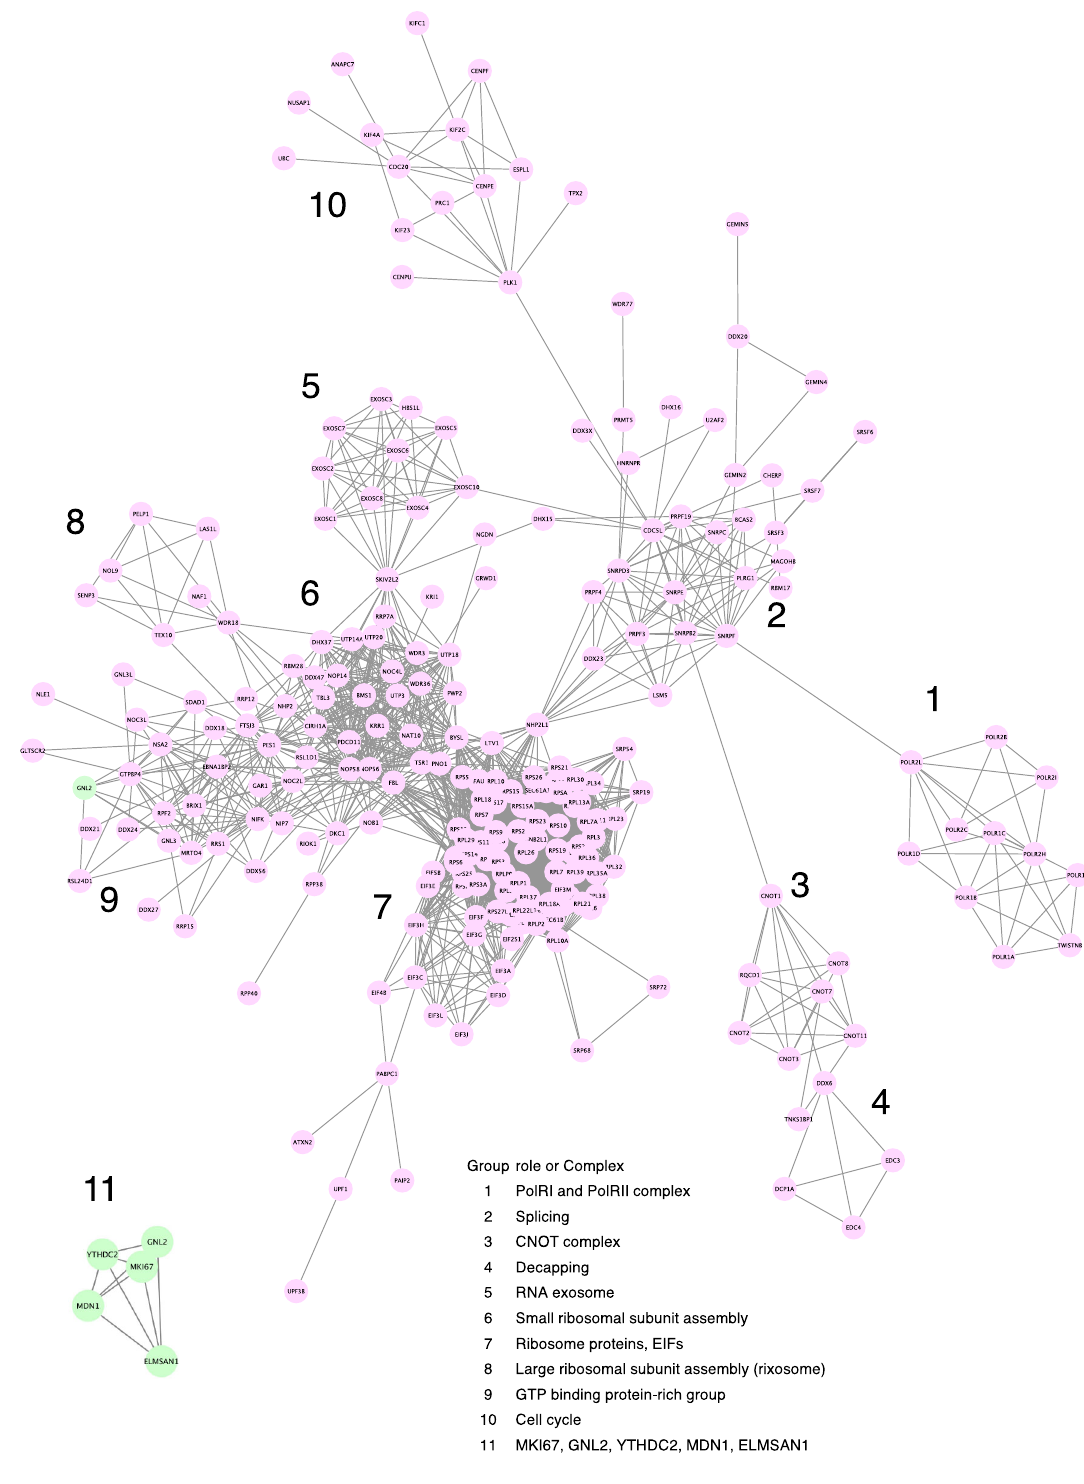
Fig. 2 RNAmetasome network. This network contains continuously edged proteins only. Proteins shown in green (#11) are the most extensively enriched but not included in this network according to the STRING database. The exception is GNL2, which is integrated as a member of the network.